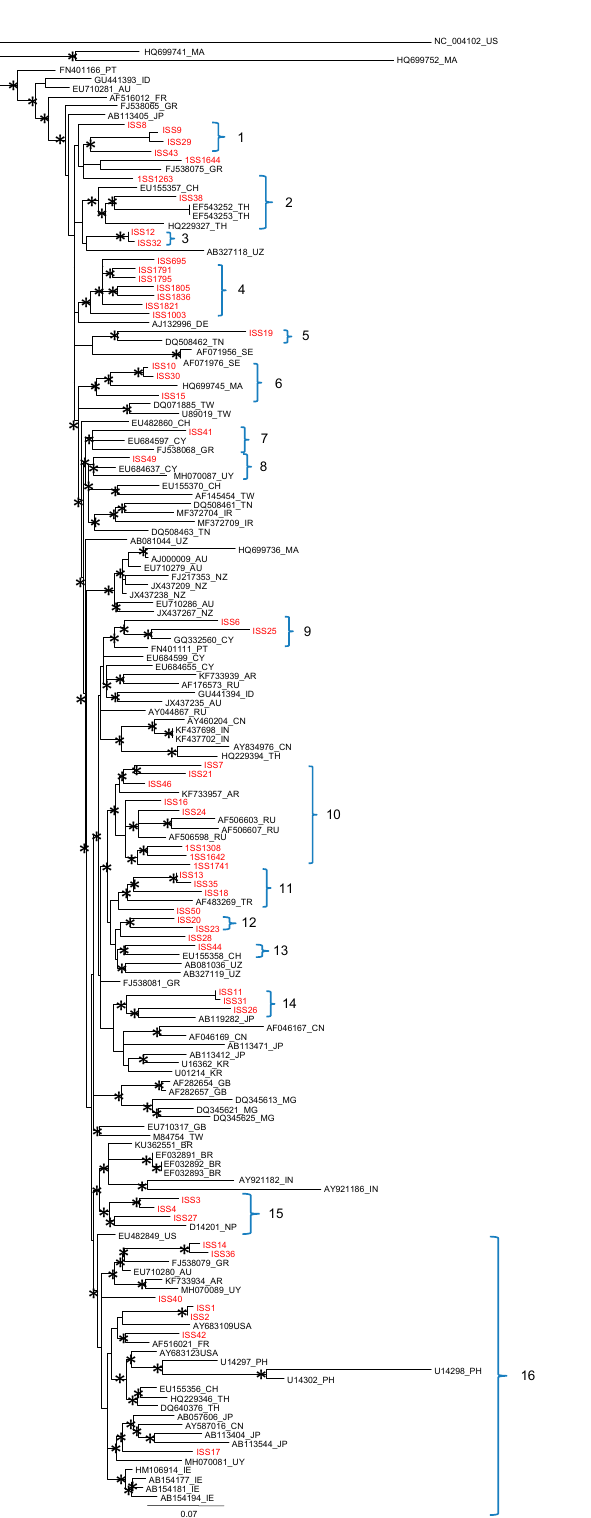
Figure 2. Maximum likelihood phylogenetic tree of the second dataset HCV1b dataset. The tree was rooted by using the midpoint rooting method. Branch lengths were estimated with the best fitting nucleotide substitution model according to a hierarchical likelihood ratio test, and were drawn to scale with the bar at the bottom indicating 0.07 nucleotide substitutions per site. The asterisk (*) along a branch represents significant statistical support for the clade subtending that branch (bootstrap support >75%). The main statistically significant sequences are highlighted with